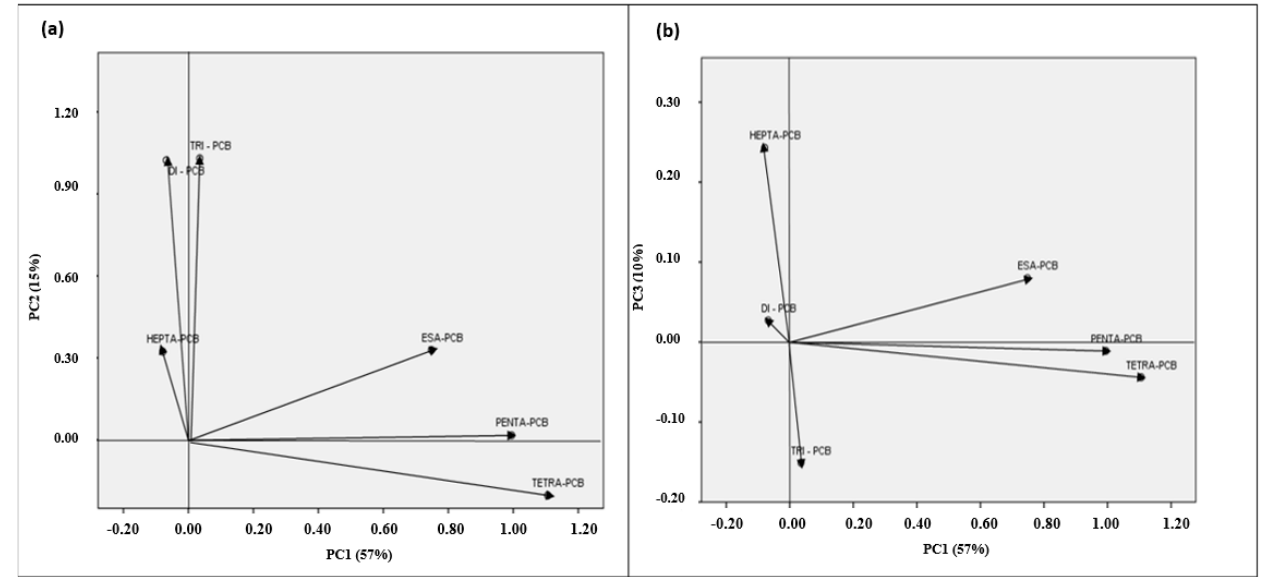
Figure 5. Principal Component Analysis (PCA) of the sediments PCBs results: ( a ) Score plot for the first and second principal component. ( b ) Loading plot for the first and third principal component.